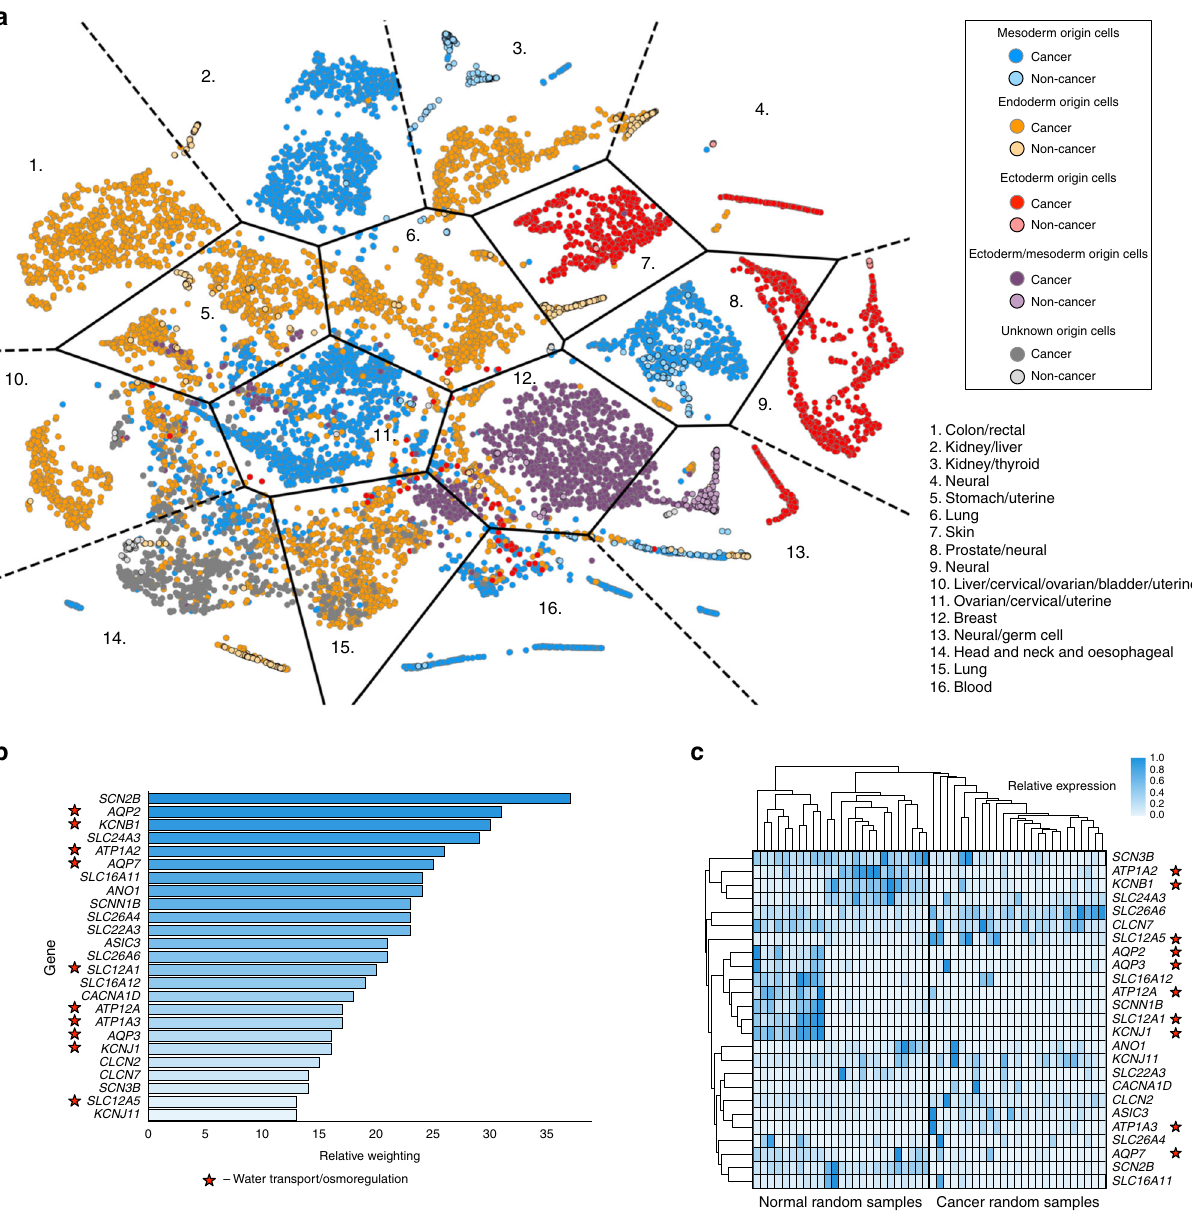
Fig. 1 Analysis of TCGA gene expression data. a Using the t-SNE dimension reduction technique applied to ion channels/membrane protein gene expression alone we show that samples cluster into subgroups classi fi ed by their cellular origin (blue — mesoderm, orange — endoderm, red — ectoderm, purple — ectoderm/mesoderm, grey — unknown), and whether they are from a sample determined to be cancer or non-cancer (dark vs. light colours). We overlay the plot with a Voronoi surface calculated from k-means centres. Within each Voronoi tile is a number, relating to the legend, which denotes the majority tissue/organ of origin of each sample in that tile. Applying a binary classi fi cation machine learning method to classify cancer vs. non-cancer sample types results in high classi fi cation accuracy. Feature weights are then extracted from the model. b Shown are the top 25 weighted features for subsamples of mesoderm origin, in particular, there are a large number of genes encoding proteins involved in movement of water — aquaporins, or involved in the osmotic response such as SLC12A1 , encoding the sodium-potassium-chloride symporter NKCC2 (starred). c Taking 25 randomly selected samples of non-cancer and cancer subtypes we plot the expression of the 25 top weighted features described previously, and show that even within a small random subset of the data, differences can be discerned in the expression of these genes between non-cancer and cancer